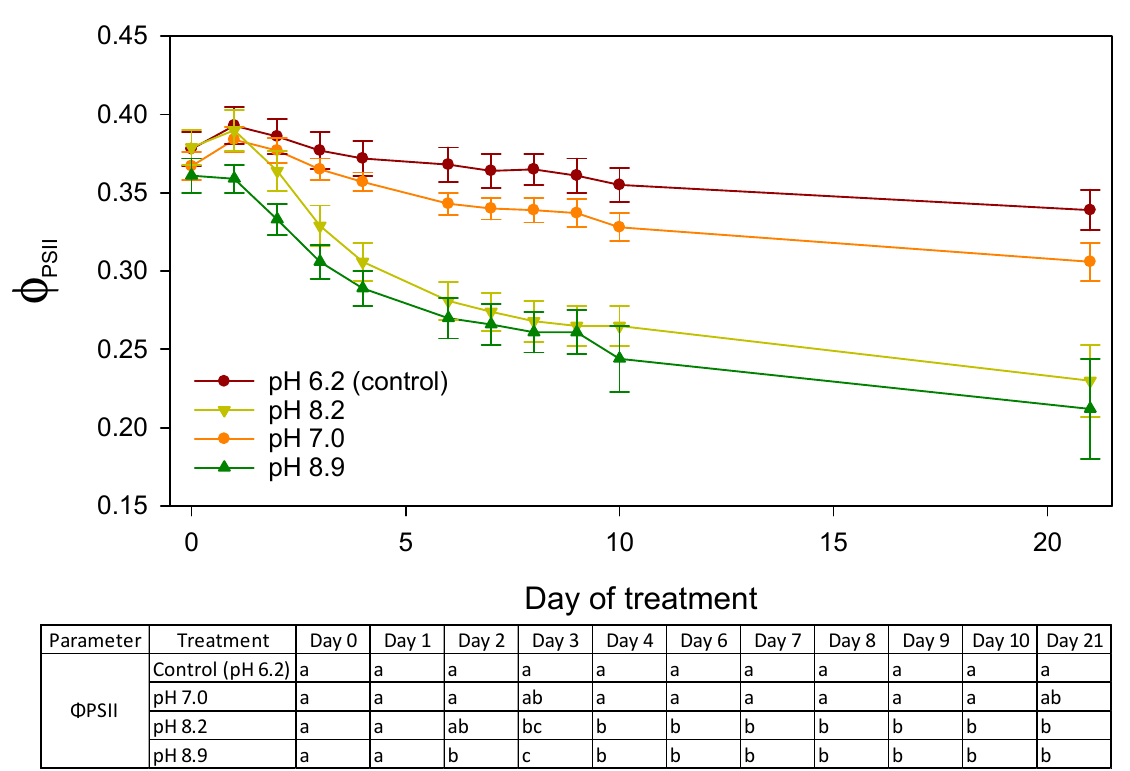
Figure 4. Time series of Φ PSII (mean ± SE) of seedlings in the treatments of control (pH 6.2), pH 7.0, pH 8.2, and pH 8.9 from day 0 (before the treatment) until day 21. Different lower-case letters denote significant differences within a day according to Tukey’s HSD test (day 0–day 20) or the Mann–Whitney U test (day 21) at p = 0.05.